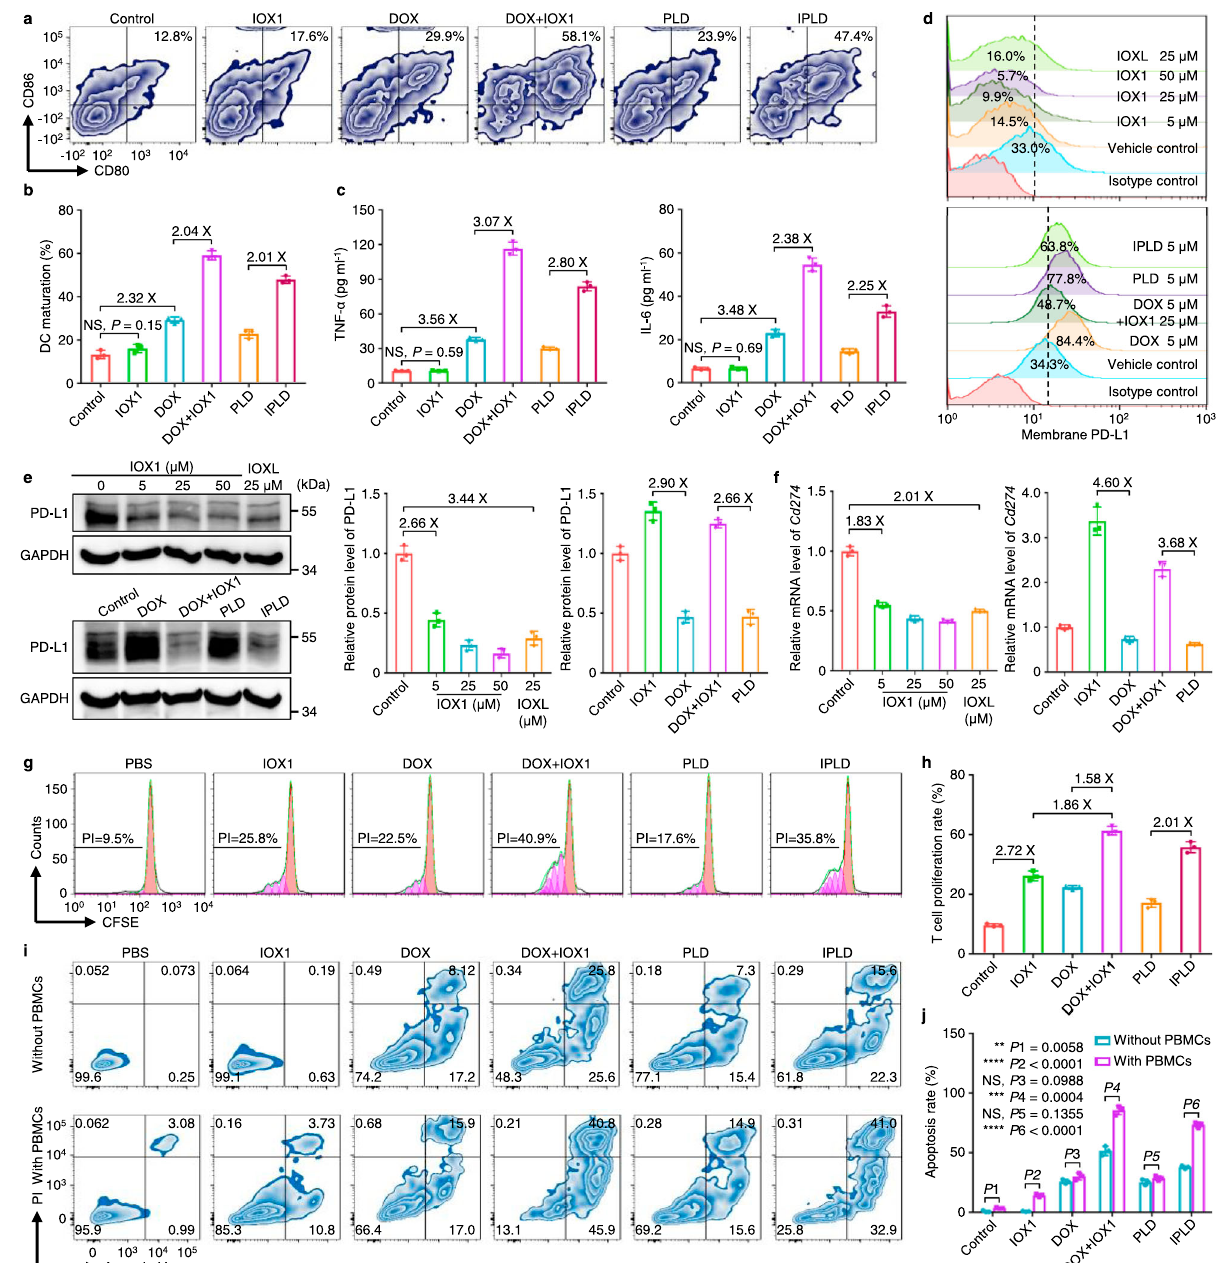
Fig. 3 IOX1 mediates dendritic cell (DC) maturation, downregulates cancer cell PD-L1 expression, and promotes T cell proliferation and activity. a – c DC maturation determined by ( a ) fl ow cytometry and ( b ) quanti fi cation of the mature DCs (CD11c + CD80 + CD86 + ), and their secretion of ( c ) TNF- α and IL-6 in supernatants; CT26 cells were pre-treated with IOX1, DOX, their combination, PLD, or IPLD; DOX dose, 5 μ M; IOX1 dose, 25 μ M; 24 h; they were co- incubated with DCs for another 24 h; n = 3 independent experiments. d – f IOX1 downregulated the endogenous PD-L1 measured by ( d ) fl ow cytometry and ( e ) western blotting and quanti fi cation, and ( f ) the Cd274 mRNA levels analyzed by qPCR in the cells; CT26 cells were treated as indicated in ( a – c ) for 24 h; n = 3 independent experiments. g – j T cell (PBMC) proliferation and cytotoxic-activity after incubating with pre-treated CT26 cells: ( g , h ) fl ow cytometric pro fi les and their calculated proliferation indices (PIs) of T cells; i , j fl ow cytometric analysis and quanti fi cations of the apoptotic CT26 cells with or without PBMCs co-culturing; CT26 cells were pre-treated as indicated in ( a – c ) for 24 h; the isolated cells were co-cultured with PBMCs in fresh medium for 3 days; the treated cells in fresh medium without PBMCs were cultured for comparison. n = 3 independent experiments. Data represent mean ± SD. Two-tailed Student ’ s t test. NS no signi fi cance; ** P < 0.01, *** P < 0.001, **** P < 0.0001. Source data are provided as a Source Data fi